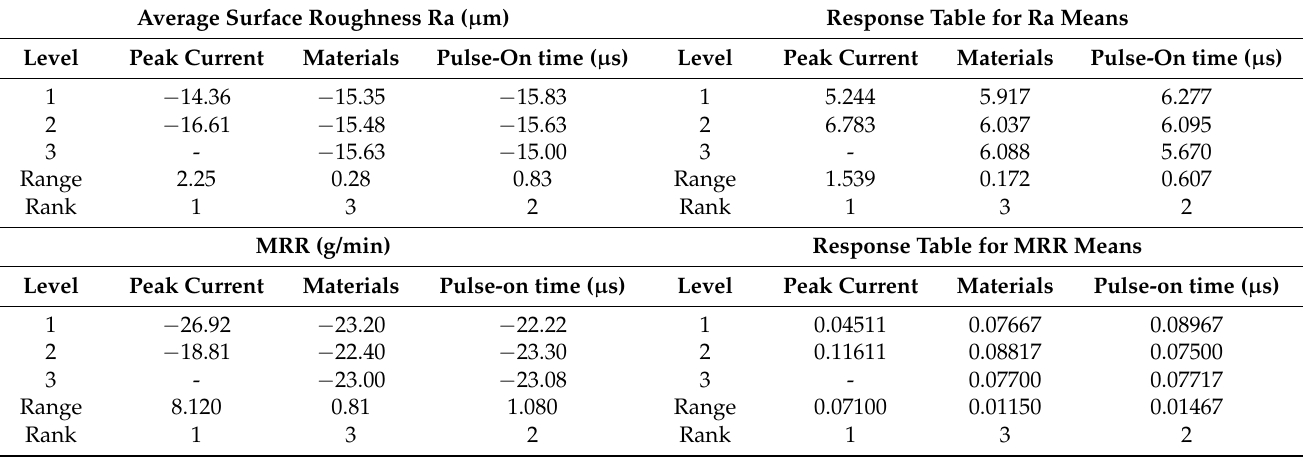
Figure 11. Comparison of predicted values and experimental results for output parameters: ( a ) av- erage surface roughness, ( b ) MRR. (CI: confidel interval, PI: predict interval). 3.4. ANOVA Analyses Analysis of variance (ANOVA) is a statistical method used to determine the individ- ual interactions of all control factors in an experimental design. In this study, ANOVA was used to analyze the effects of pulse-on time, materials and peak current on average surface roughness and MRR. This analysis was carried out at a 5% significance level and a 95% confidence level. In ANOVA, the significance of the control factors is determined by comparing the F values of each control factor [34–36].